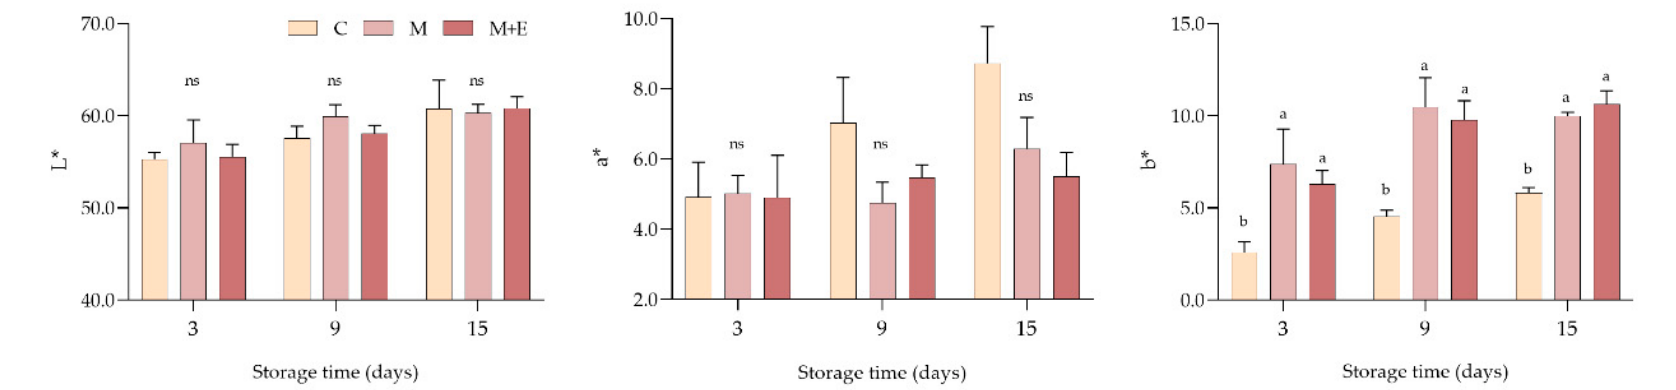
Figure 2. Average lightness (L*), redness (a*) and yellowness (b*) values of non-marinated (C), marinated (M) and marinated with essential oils (M + E) pork loin slices at 3, 9 and 15 days of refrigerated storage. Data represent means ± SD. a, b = average values lacking a common letter significantly differ among the same sampling time. At the same storage time, ns indicates no significant differences among the samples.